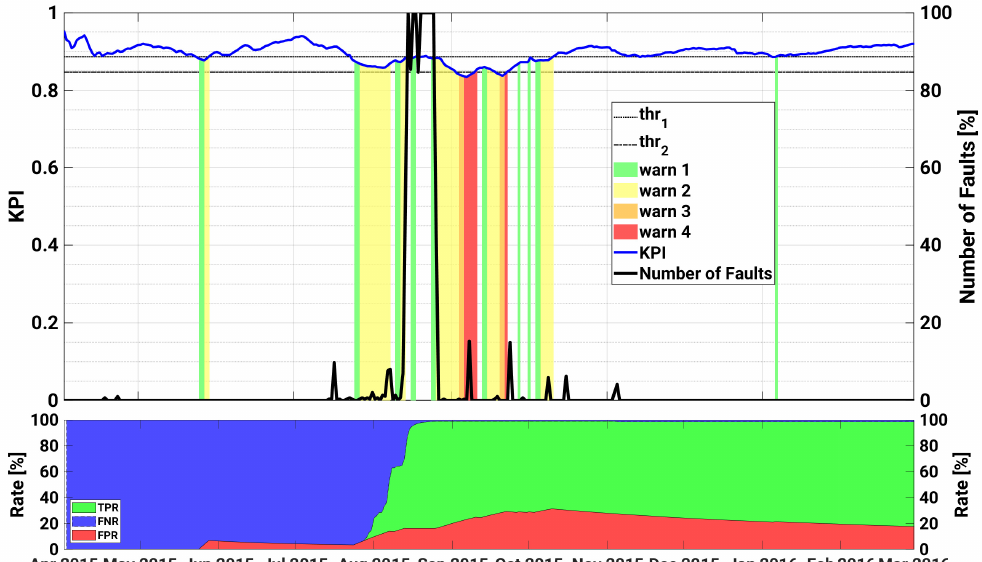
Figure 6. Historical case studies for inverter B.1 of plant B. Top plot—Left axis: KPI, as well as the warning levels and the upper and lower thresholds are shown as a function of datetime; Right axis: time series of daily number of faults. Bottom plot: TPR, FNR and FPR as a function of